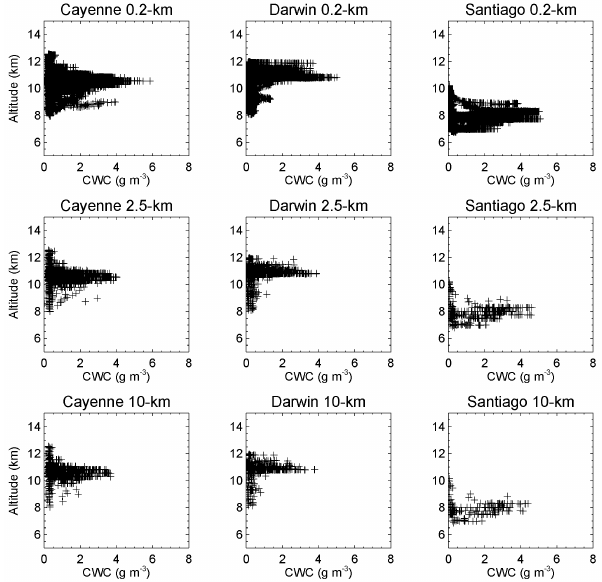
Figure 2. Total condensed water content (CWC) measurements by the Robust probe during flight tests from Cayenne (left column), Darwin (middle column), and Santiago (right column). Measure- ments are included only for air temperatures were below − 20 ◦ C, where liquid water contributions are expected to be negligible. Con- sidering a typical air speed of 200ms − 1 , 1Hz measurements cor- responding to a horizontal length scale of roughly 0.2km (top row) slightly exceed those averaged over 2.5 and 10km length